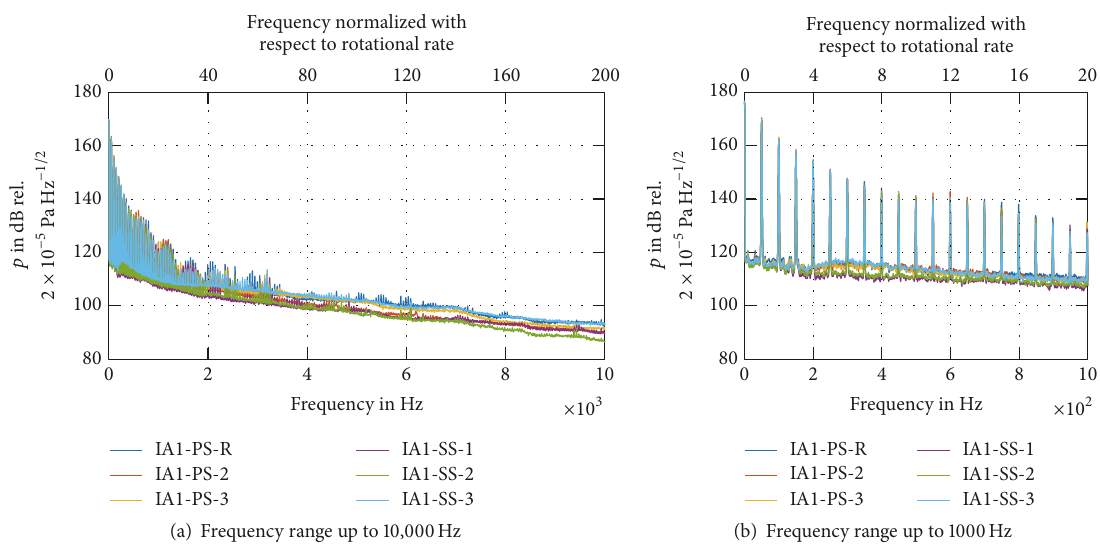
Figure 14: PSD of blade surface pressure at a rotational speed of 𝑓 = 50 Hz and operating point Δ𝑝 12, red = 28,000Pa.